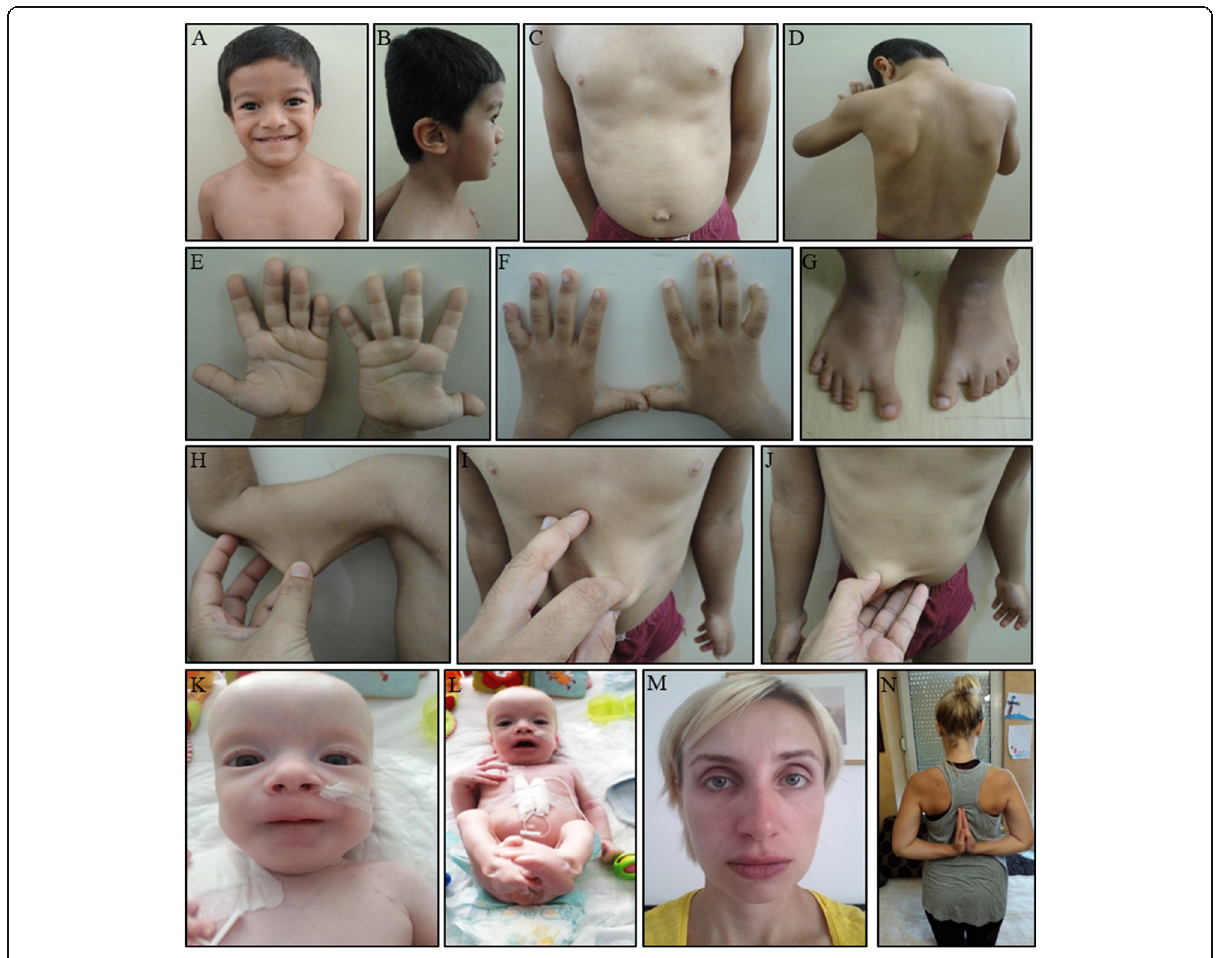
Fig. 4 Clinical features. In the five-year old Indian patient (case A) the following features were noted: ( a ) flat face, telecanthus, orbital fullness, upslant of palpebral fissures, prominent nasolabial folds, ( b ) brachycephaly, midface retrusion and low-set ears, ( e , f ) mild brachydactyly and a deformed right thumb due to an unstable and lax interphalangeal joint, ( g ) broad and medially deviated great toes with sandal gap and flat feet and ( c , d , h , i , j ) extra skin folds and significant skin laxity. The proband of family B presented with ( k , l ) hypertelorism, pectus excavatum, clubfeet and hypermobile joints whereas the mother (III-2) demonstrated hypertelorism and joint hypermobility ( m , n